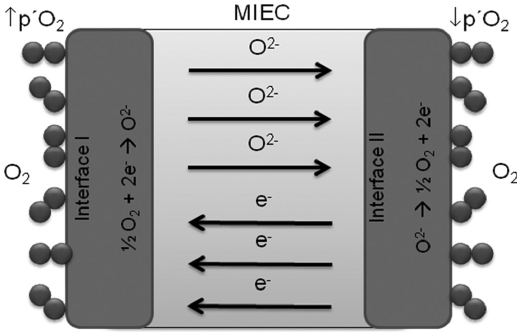
Figure 3. Oxygen transport through a MIEC